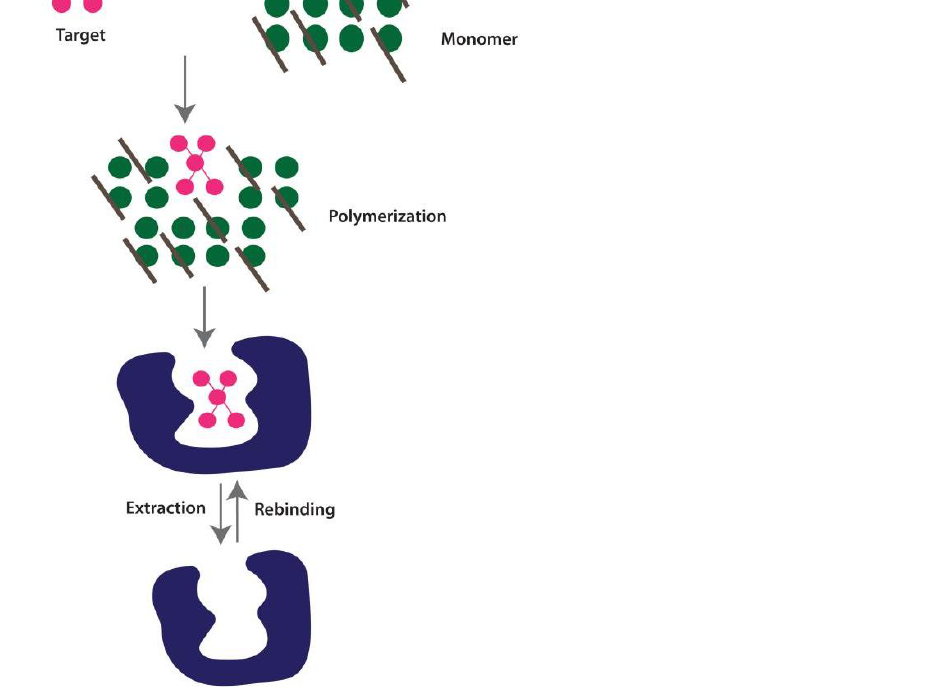
Figure 5. Figure illustrates the principle of molecular imprinting technology (MIT)- based diagnosis. A monomer and a cross-linker that surround the target molecule go through a process called polymerization to create MIP. This monomer – target molecule assembly is facilitated by both cova- lent and non-covalent interactions. The target molecule is complementary in shape to the